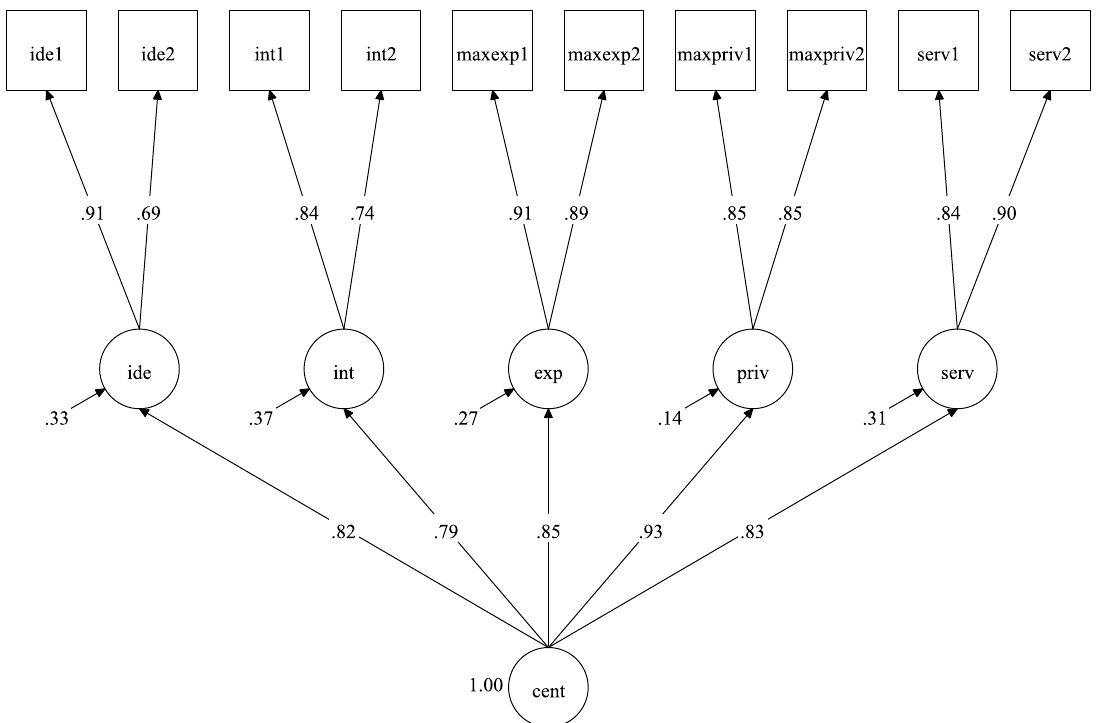
Figure A6. Results of the confirmatory factor analysis of the CRSi-14. The numbers in the plot represent standardized estimates. Cent = centrality of religiosity; int = intellect; ide = ideology; serv = public practice; priv = private practice; exp = experience; max = this prefix means that out of two items, only the one with the higher value for this core dimension is processed in the analysis. The number after the item name indicates the position of the item within the core dimension items. Squares depict manifest and circles latent variables. Residual arrows are not shown for the manifest variables. Numbers on arrows are factor loadings. The model is identified by setting the variance of the second level latent variable “cent” and the factor loading of each item with the suffix “1” to be equal 1. All reported estimates are significant at least α ≤ 0.05 level.